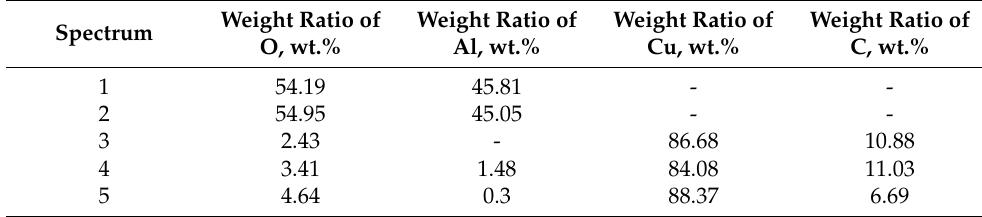
Table 8. Chemical analysis of the kerf. Spectrum